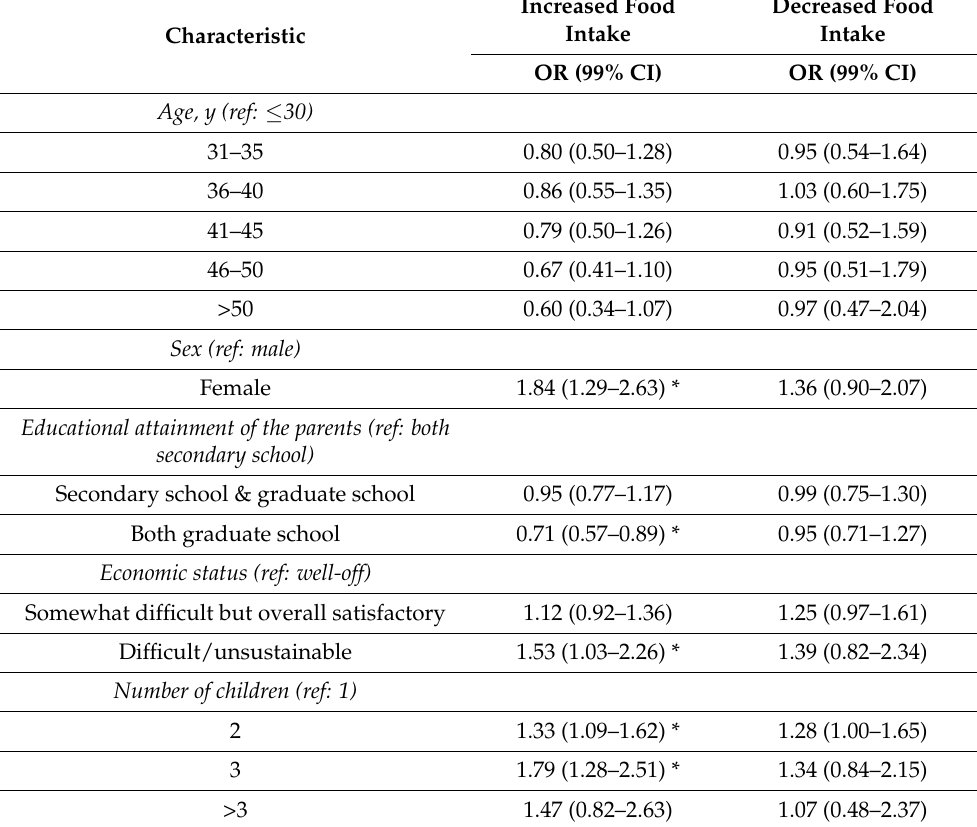
Figure 3. Changes in children’s food intake and body weight after COVID-19 outbreak. Table 4. Multivariable logistic regression analysis of increased and decreased vs. unchanged chil- dren’s food intake after COVID-19 outbreak. Results are presented as odds ratios (ORs) and 99% confidence intervals (CIs).